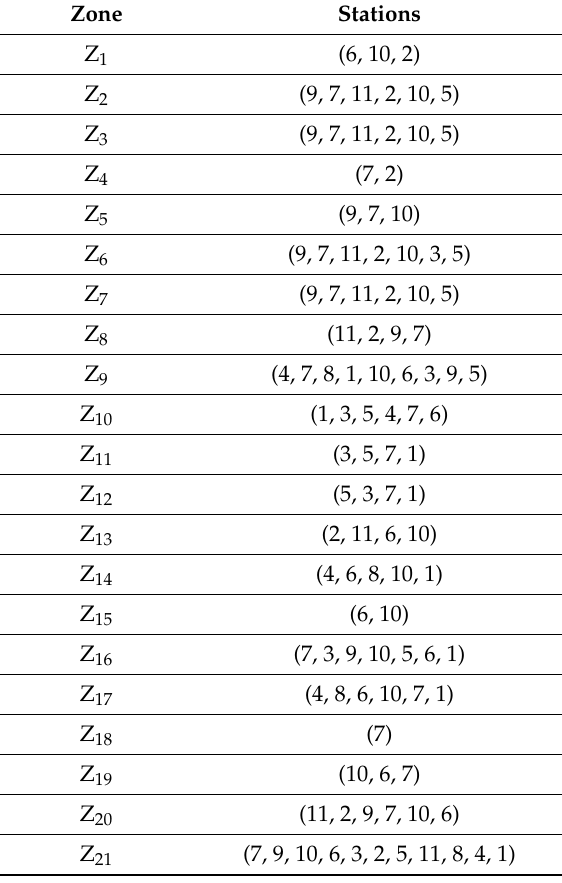
Table 1. Constrained numbered weather stations for each Global Energy Forecasting Competition 2012 (GEFCom2012) load zone.